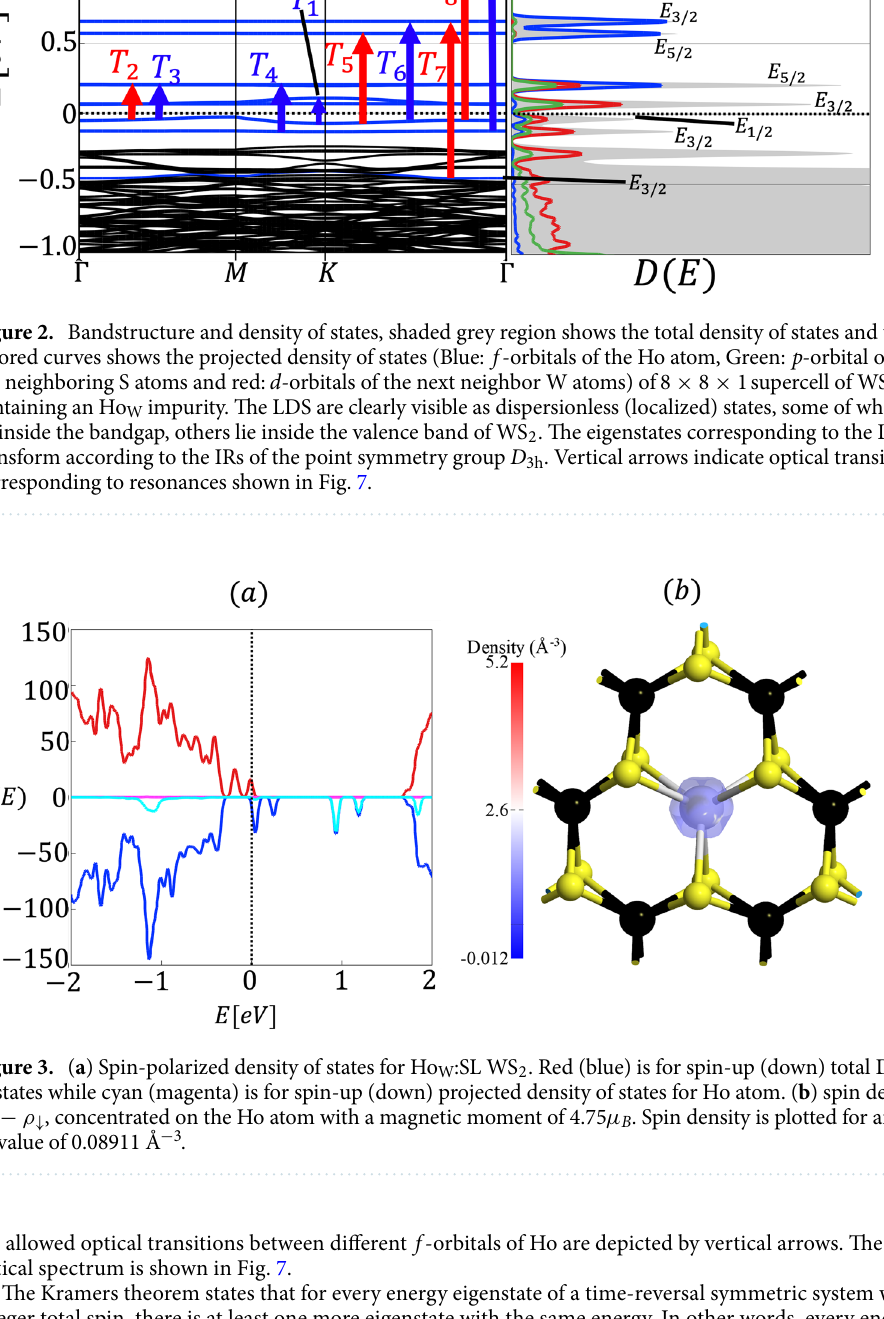
Figure 3. ( a ) Spin-polarized density of states for Ho W :SL WS 2 . Red (blue) is for spin-up (down) total Density of states while cyan (magenta) is for spin-up (down) projected density of states for Ho atom. ( b ) spin density ρ ρ , concentrated on the Ho atom with a magnetic moment of 4.75 µ B . Spin density is plotted for an ↑ − ↓ isovalue of 0.08911 Å − 3